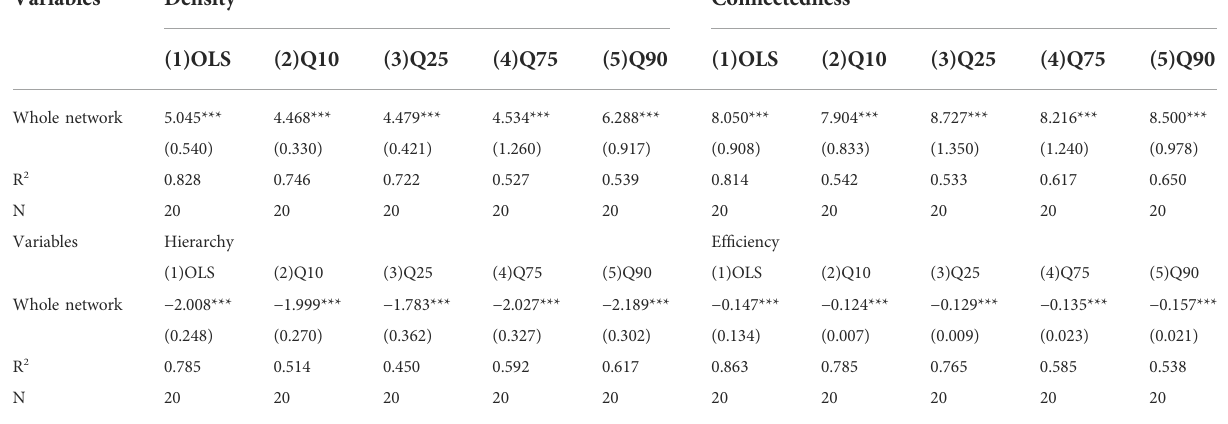
TABLE 5 Results of the impact of the overall network structure on ALTFP.